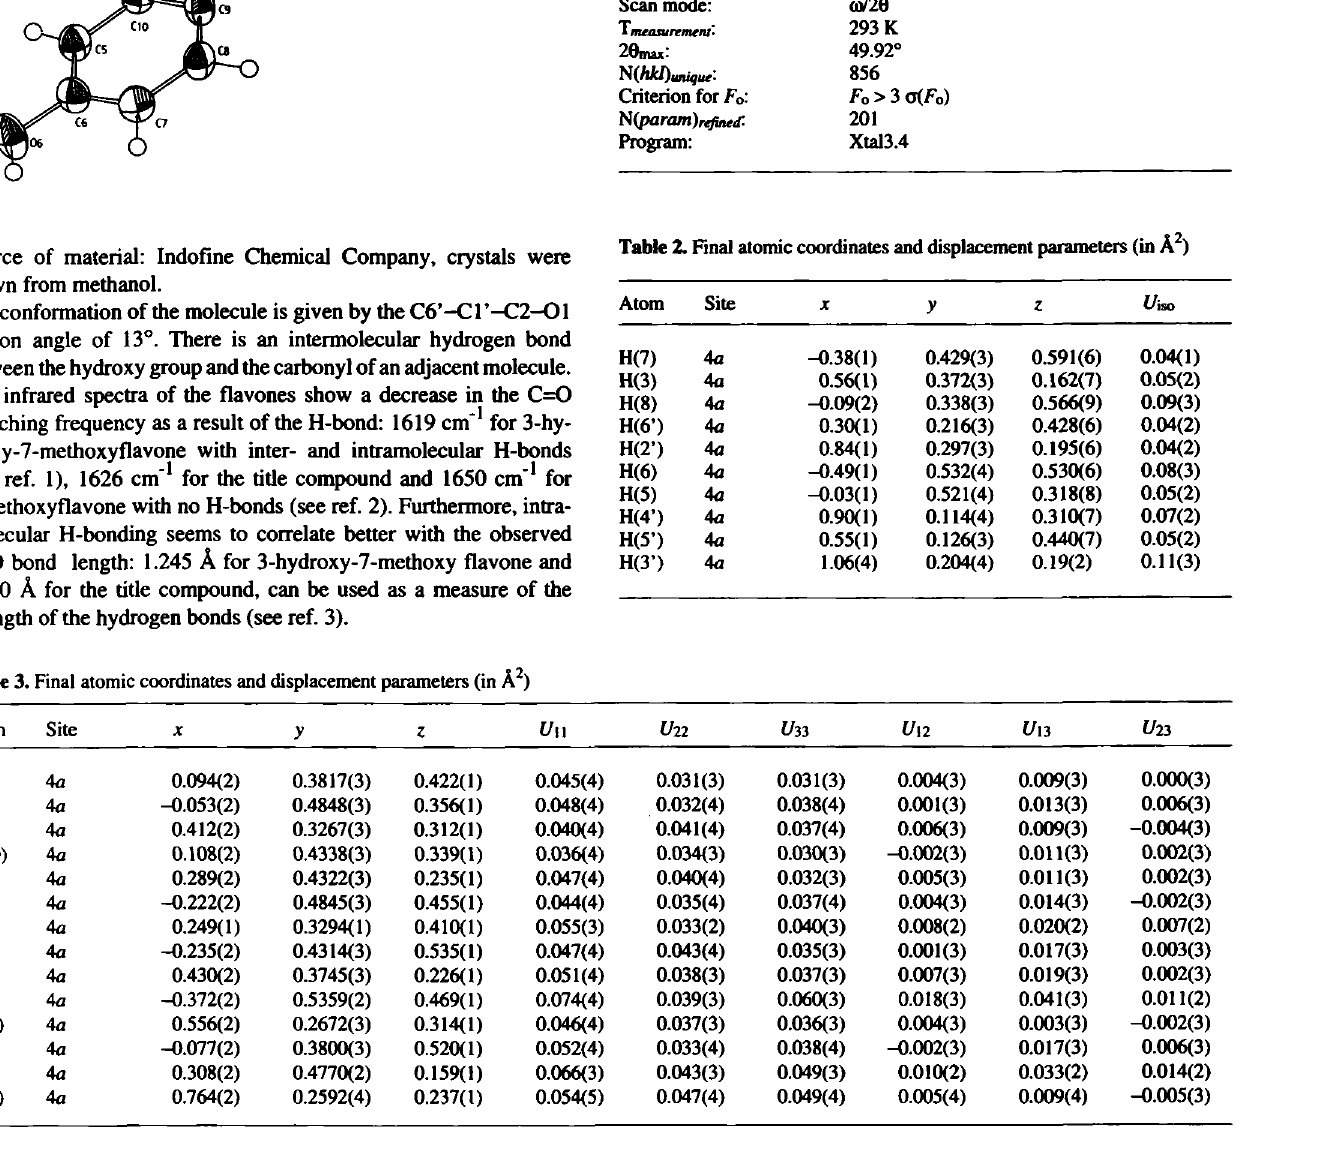
Table 1. Parameters used for the X-ray data collection Crystal: